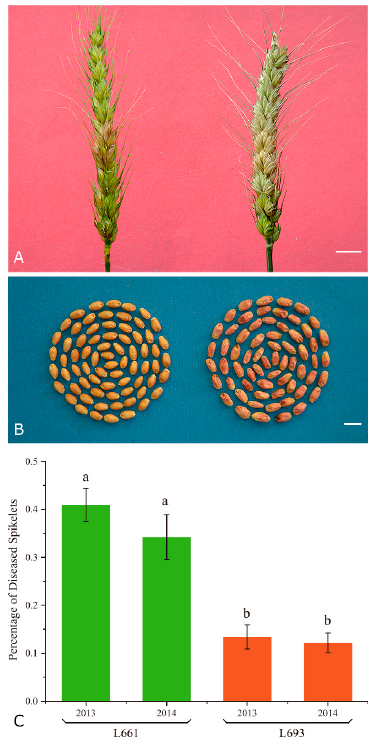
Figure 1. Comparisons of L693 and L661 in terms of Fusarium head blight (FHB) severity and differentially expressed genes. ( A ) Photograph of spikes of L693 (left) and L661 (right), grown under greenhouse conditions, 21 days after inoculation with Fusarium graminearum in 2013. For L693, disease symptoms are visible only in the inoculated spikelet, whereas, for L661, they are evident in the entire spike. Bars, 1 cm. ( B ) Comparison of kernel health between the resistant line L693 (left) and the susceptible line L661 (right) in 2013. The kernels of L693 were fully filled, while those of L661 were shriveled and pinkish. Bars, 1 cm. ( C ) Multiple comparison of the percentage of diseased spikelets (PDS) in 2013 and 2014. Error bars indicate the standard error of PDS;. Means with the same letter (above error bar) are not significantly different ( p > 0.01) and with different letter are significantly different ( p ≤ 0.01).